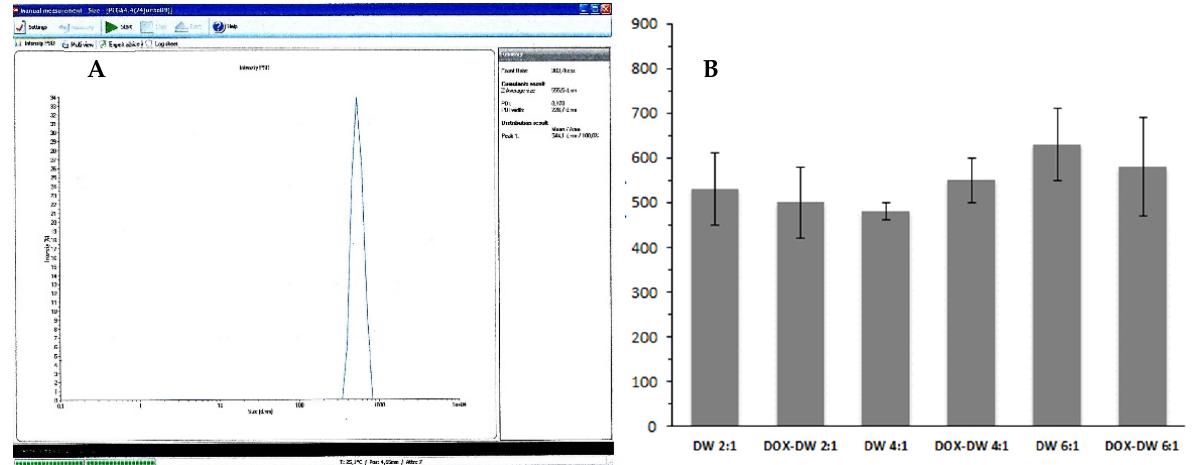
600 nm for 4:1 and 450–730 nm for 6:1 for DOX-loaded DWNPs.